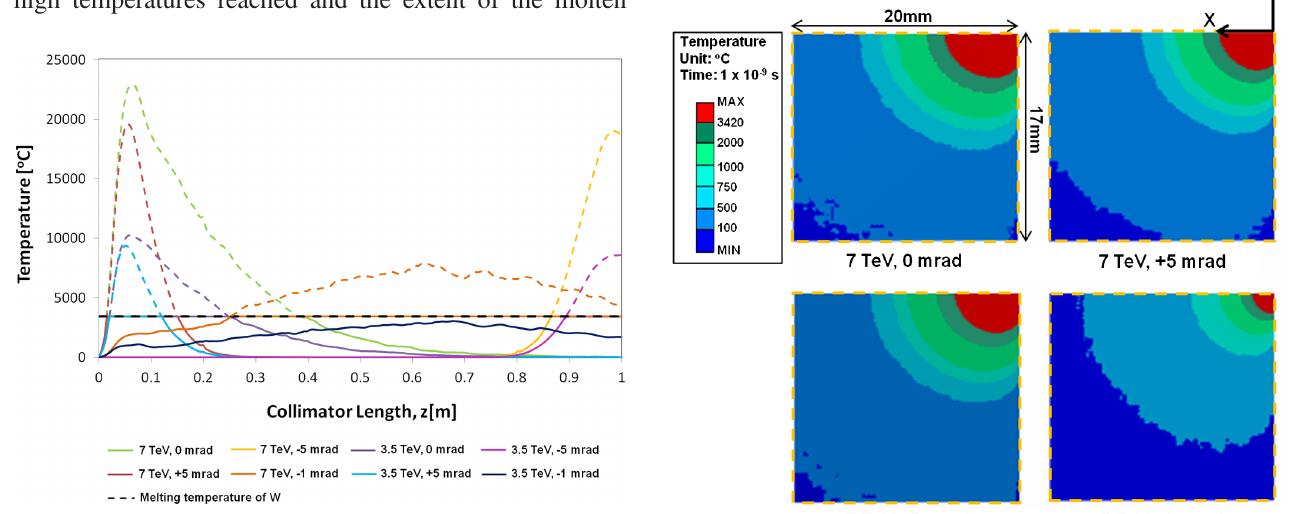
FIG. 16. Comparison of the cross-sectional temperature dis- tribution at the T -section just after the impact at 7 TeV. The red max region represents temperatures exceeding the melting temperature of W ( 3420 °C). The enclosed area is the same as that shown within the dashed line in Fig.